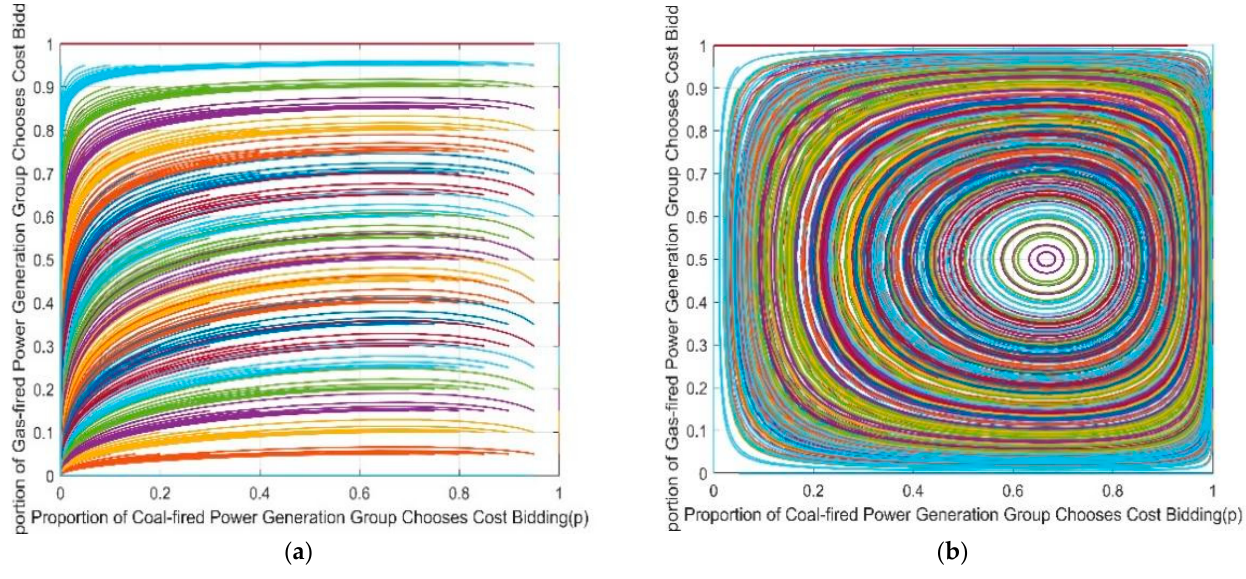
Figure 10. Evolution trend of bidding entities in phase 3 under scenario 2. ( a ) Simulation results of the evolution of the cost of coal-fired electricity from August to December 2020 and April and June 2021 with a slightly higher cost of electricity than gas-fired electricity, ( b ) Simulation results for the evolution of a gas-fired power producer with a higher feed-in tariff for lower electricity prices. The conditional relations in scenario 2.2-b are shown in inequalities (38) and (39):